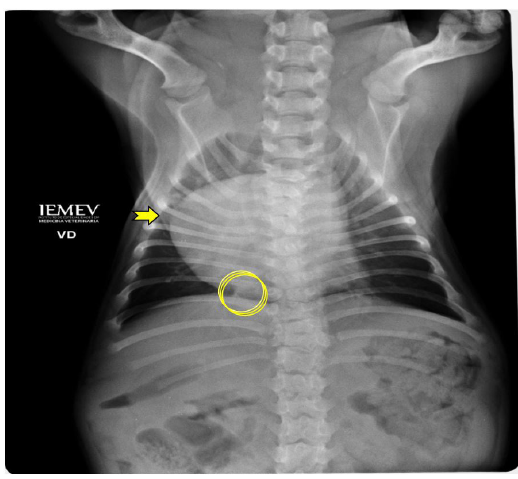
Figure 1. Thoracic X-ray image in the ventrodorsal projection with right atrioventricular enlargement, inverted “D” image (Arrow), and dilatation of the caudal cava vein (Circle) Source: courtesy of Dr. Denise Soares.